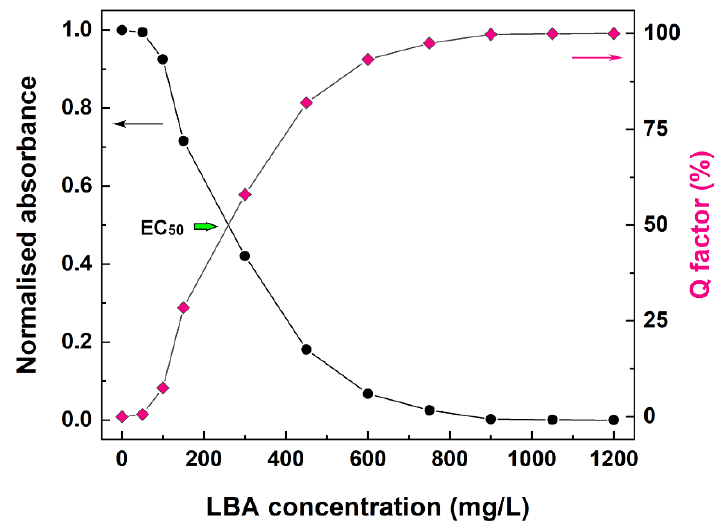
Figure 7. Results of the 2,2-diphenylpicrylhydrazyl (DPPH) antioxidant assay. Normalized ab- sorbance at 517 nm (black circles, y -axis on the left-hand side) and Q factor values (magenta diamonds, y -axis on the right-hand side) versus LBA concentration released from the zein-LBA films. The green arrow indicates the value of EC 50 .